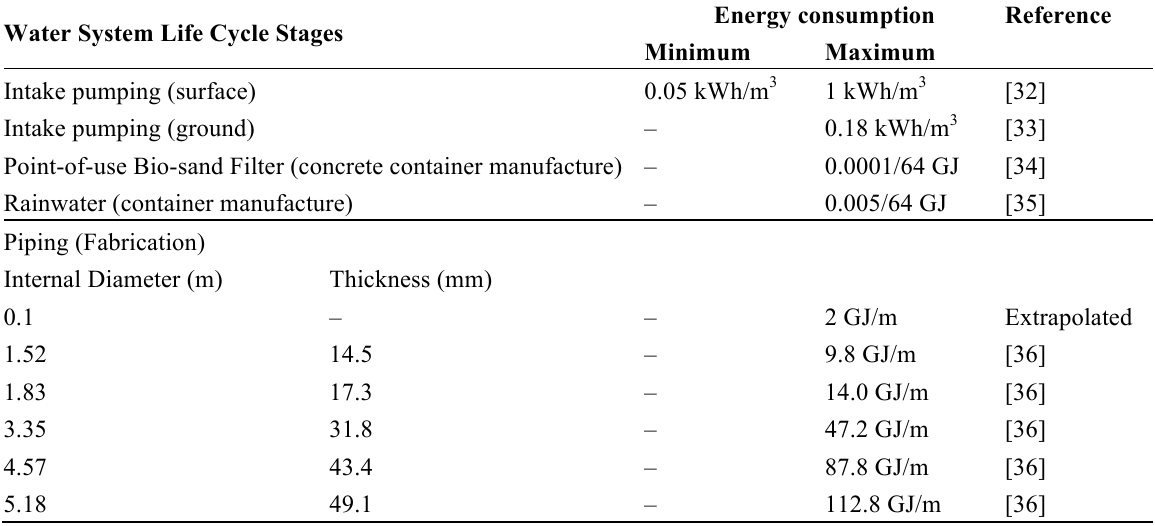
Table 7. Water system energy consumption for various life-cycle